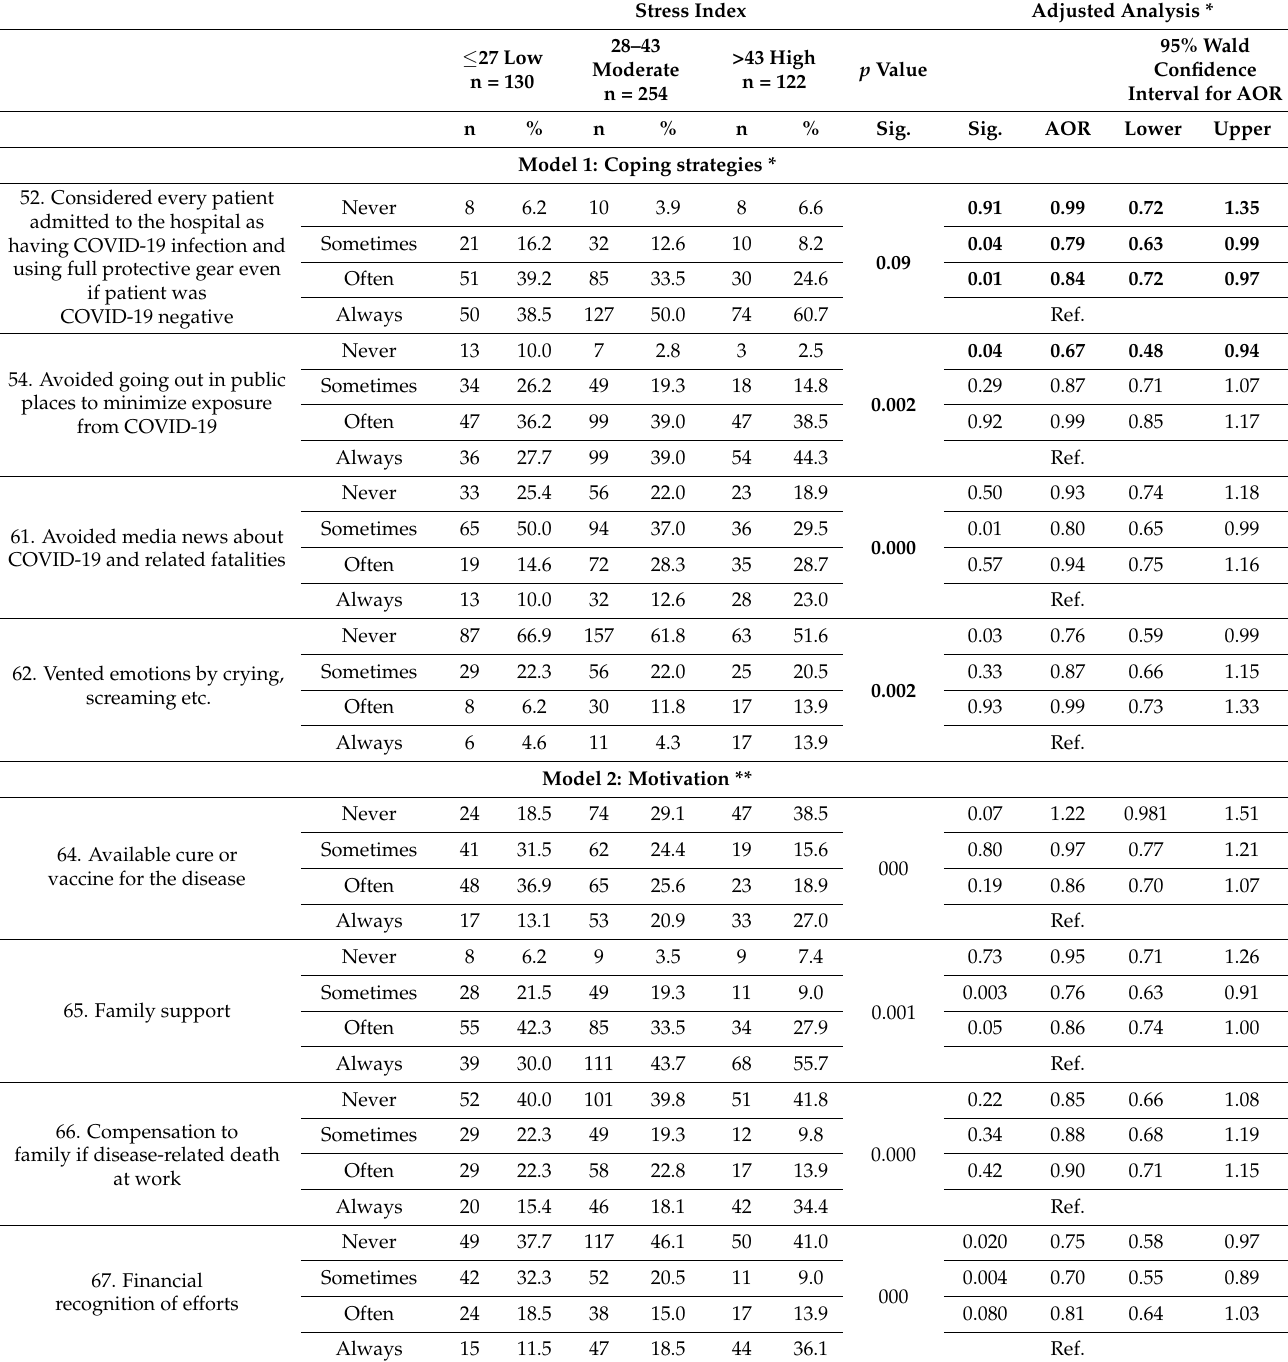
Table 3. Associations between respondent coping strategies and motivation factors with COVID-19 and stress scoring index during COVID-19